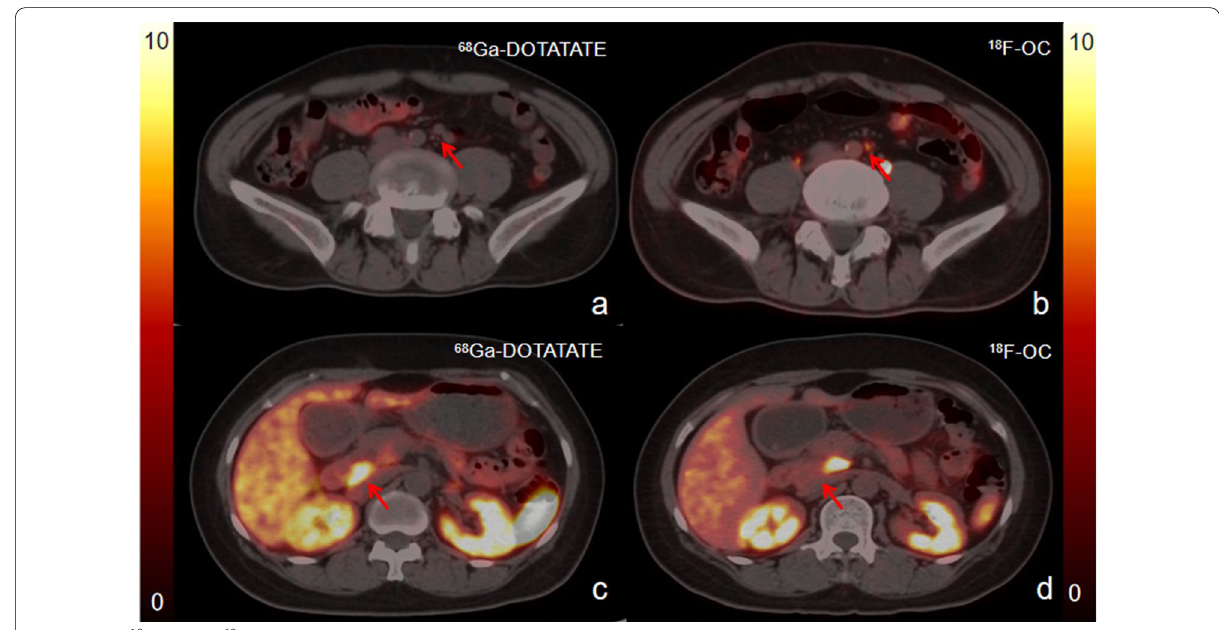
Fig. 3 Both 18 F-OC and 68 Ga-DOTATATE had lesions that could not be detected by another imaging agent. PET/CT images acquired with 68 Ga-DOTATATE and 18 F-OC for patient No. 19 ( a , b ) and No. 20 ( c , d ). The 18 F-OC fusion image ( b ) found an increased uptake in a retroperitoneal lymph node, while the uptake of this lymph node was not significantly increased on 68 Ga-DOTATATE ( a ) image. However, in another patient, the 18 F-OC fusion image ( d ) shows that the uptake in one retroperitoneal lesion was not obvious, while the uptake of 68 Ga-DOTATAE was significant ( c )